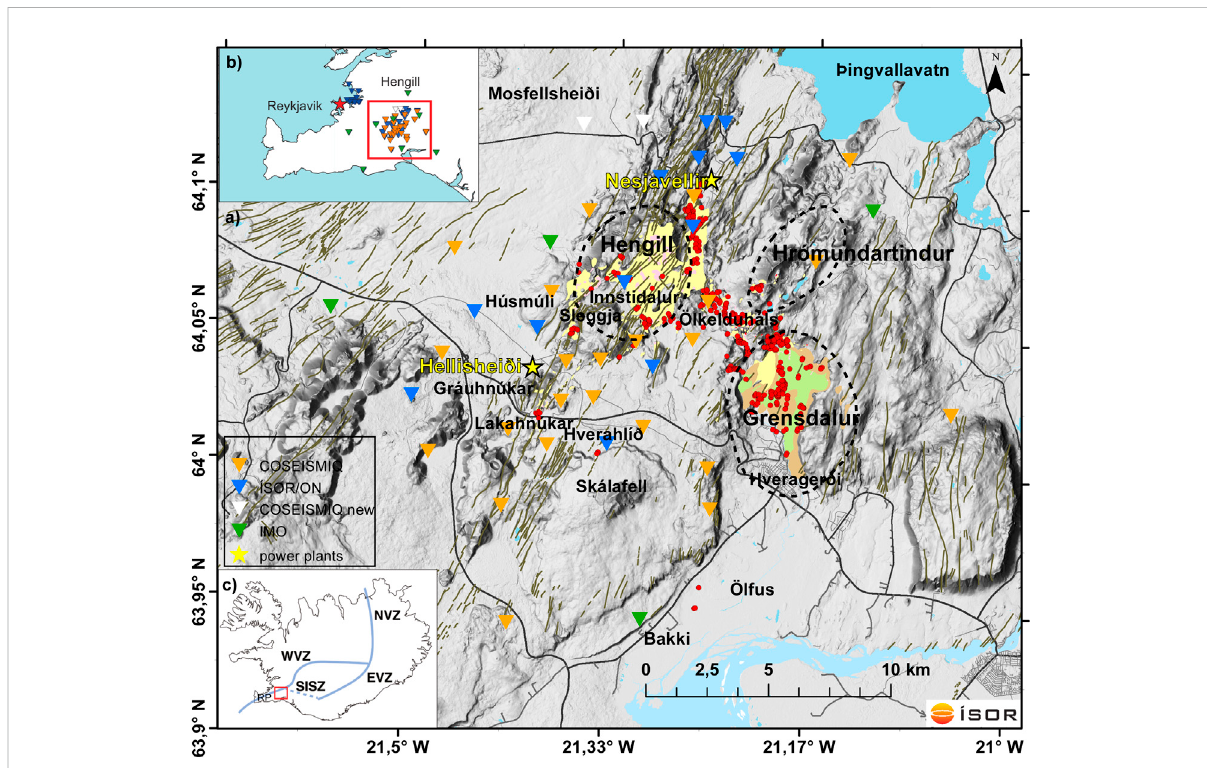
FIGURE 1 (A) The Hengill high-temperature geothermal area including the location of all names that appear in this paper overlaid on a topographic map.SeismicstationsfromthepermanentOR(blue)andVI(green)networksandthetemporary2Cnetwork(orange)areshownasinvertedtriangles. White triangles are late deployed 2C stations that are not included in the tomographic analysis. Red dots are fumaroles; regions with surface geothermal alteration are shown in yellow (Sæmundsson et al., 2016). Black dotted lines mark the three volcanic centers (Árnason et al., 1986). Fault and fractures are shown in grey (Sæmundsson et al., 2016), roads as black lines and yellow stars are the power plants at Hellisheiði (south) and Nesjavellir(north).Theinset fi guresshow (B) azoomintothestudyareagivinganoverviewoftheextendedseismicnetworkandin (C) thelocationof the study area in the Hengill volcanic complex (red rectangle) at the triple junction of the Western Volcanic Zone (WVZ), the South Icelandic Seismic Zone (SISZ), and the Reykjanes Peninsula Oblique Rift